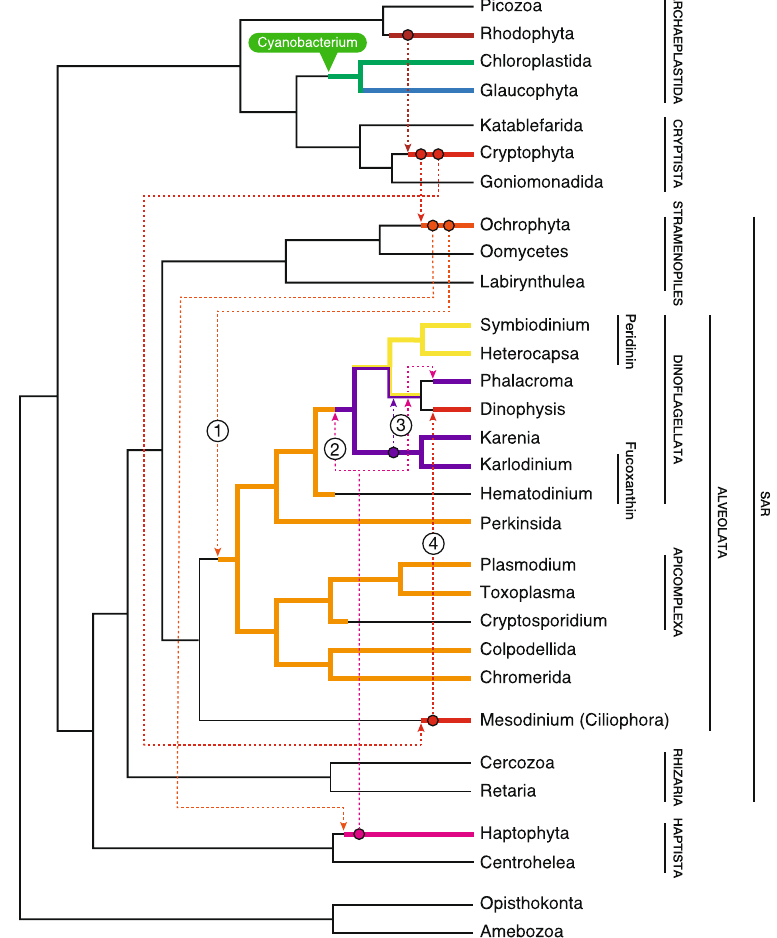
Figure 5. Schematic illustration of the proposed mechanism of plastid acquisition in Dinophysis . The model proposed by Bodył (2018) 2 was modified. (1) A common ancestor of dinoflagellates, perkinsids, apicomplexans, colpodellids and chromerids acquired plastids from Ochrophyta. (2) The ancestor of peridinin dinoflagellates acquired a haptophyte plastid and evolved into both the peridinin and fucoxanthin dinoflagellates that exist today. (3) Dinophysis retained the original haptophyte plastid or evolved a peridinin plastid and then acquired a new plastid from either haptophytes or Kareniaceae, which possess the original haptophyte plastid. Dinopysis subsequently evolved into two lineages: a lineage that primarily possessed the haptophyte plastid, e.g. Phalacroma mitra , and (4) a lineage that switched from using a haptophyte to using a cryptophyte plastid via Mesodinium